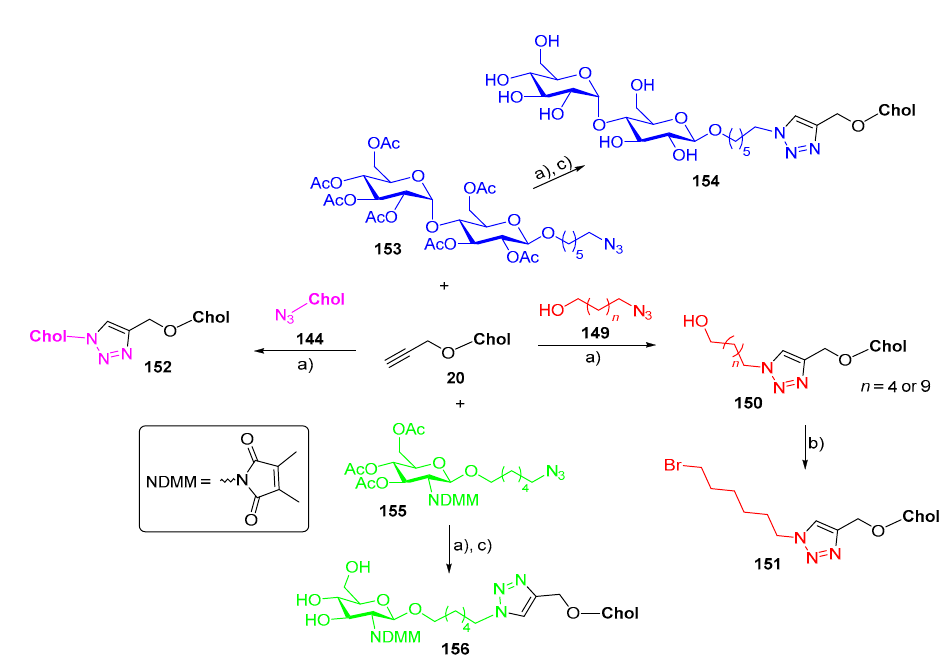
Scheme 34. Synthesis of cholesterol-triazole dimer, cholesterol-triazole alkanes, and cholesterol- triazole carbohydrates. Reagents and conditions: a ) CuSO 4 ∙ 5H 2 O, L -AA, THF/H 2 O (5:1), reflux, 3 h; b